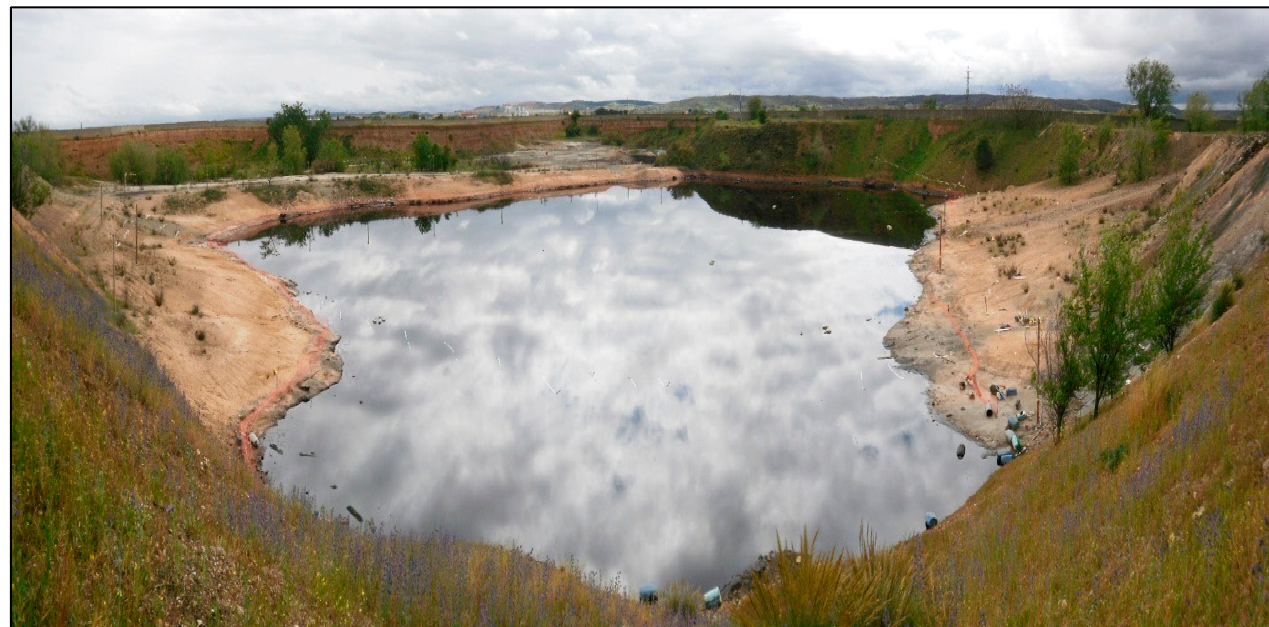
Figure 1. Initial situation of the waste pond at Arganda del Rey, Madrid.